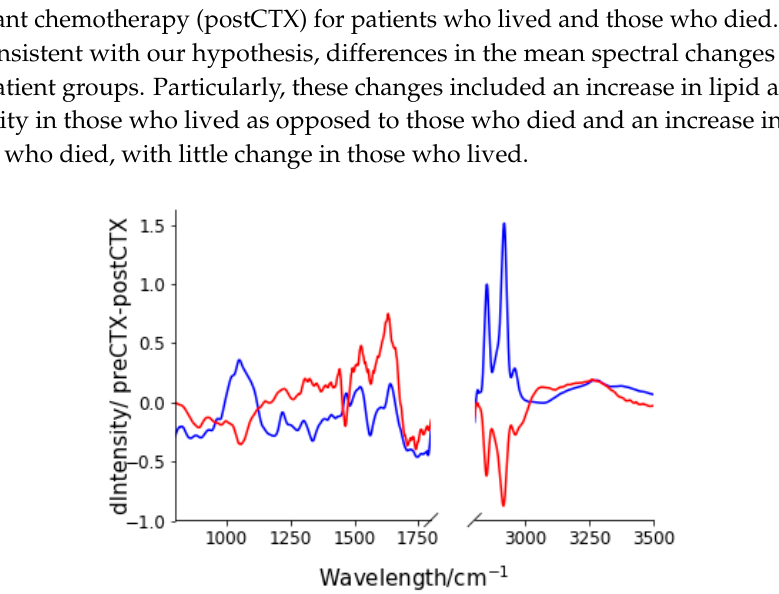
Figure 3. Spectral changes after neoadjuvant chemotherapy (neoCTX) for patients who lived (blue) and for those who died (red). Spectral changes were calculated by subtracting the mean, standardised and normalised spectra after post-neoadjuvant chemotherapy (postCTX) from that of the pre-neoadjuvant chemotherapy (preCTX) for each group.